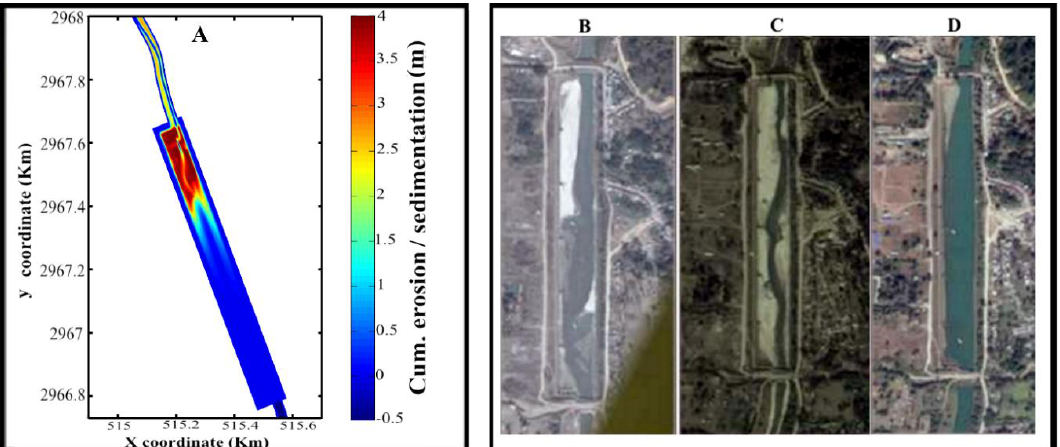
Figure 5. The similarity between Delft3D results and the actual situation captured from Google Earth ( A ) Delft3D results, ( B ) the actual case in 2004, ( C ) the actual case in 2005, ( D ) the actual case in 2016.